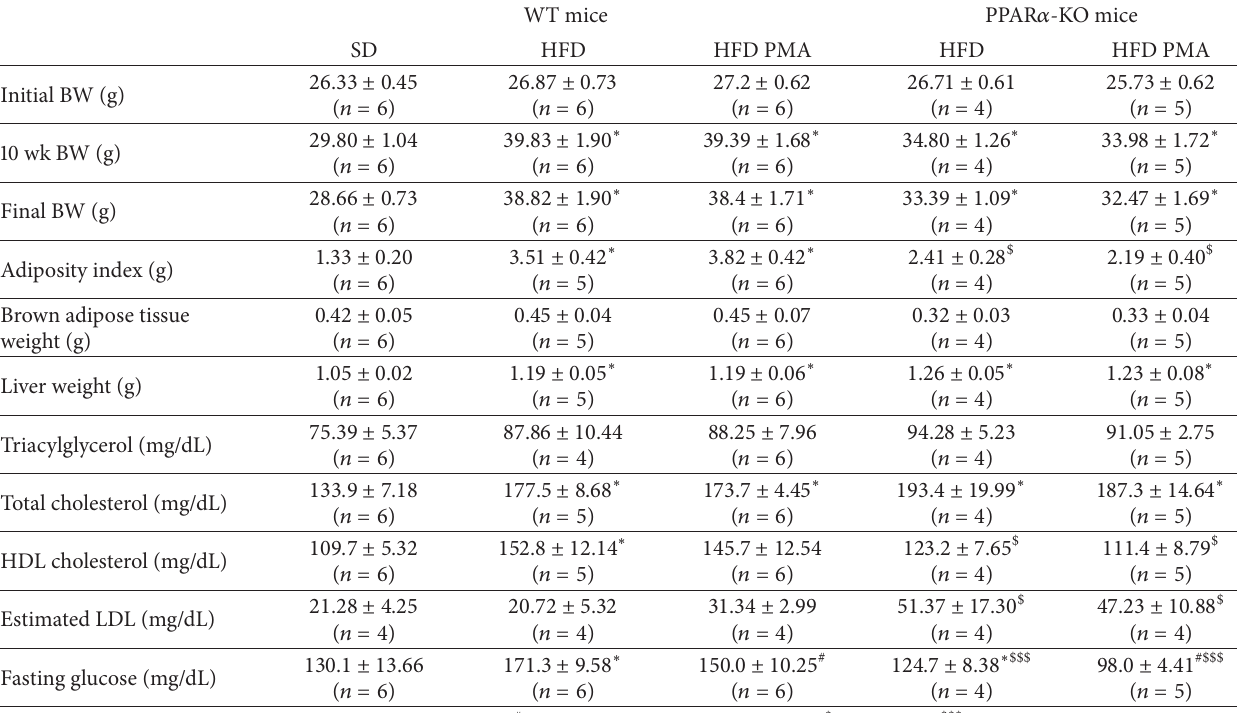
Table 2: Body weight (BW); tissue masses; and plasma levels of triacylglycerol, total cholesterol, HDL, estimated LDL, and fasting glycemia in wild-type (WT) and PPAR 𝛼 -knockout (KO) mice fed with a standard diet (SD) or a high fat diet (HFD) and either untreated or treated with oleic acid (HFD) or palmitoleic acid (HFD